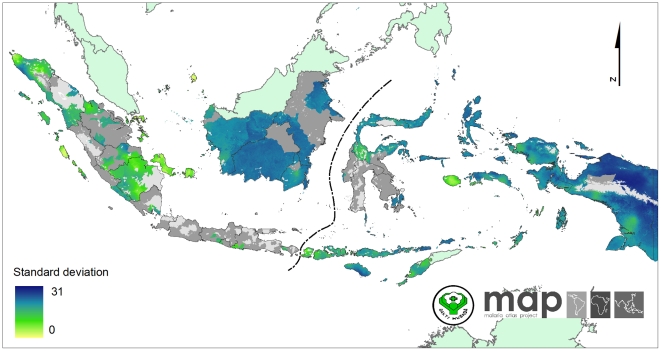
The standard deviation map of predicted PfPR2-10 within the stable transmission areas.These values indicate an index of relative uncertainty. Dark blue areas represent where predictions were made with large uncertainty. Yellow areas represent where predictions were made with small uncertainty.